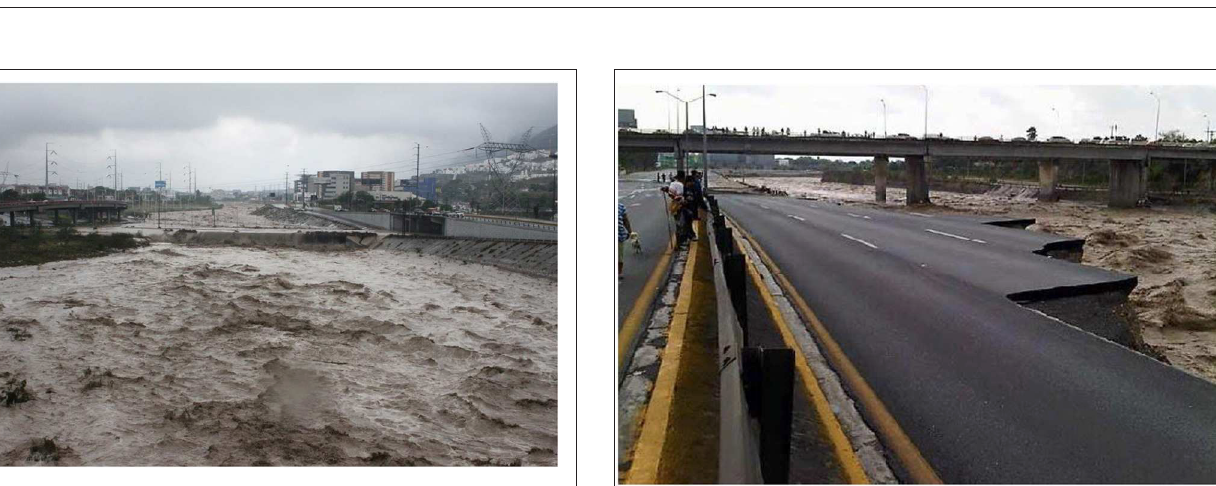
FIGURE 3 | Peak flow Santa Catarina River and maximum daily precipitation (MMA), 1988–2016.